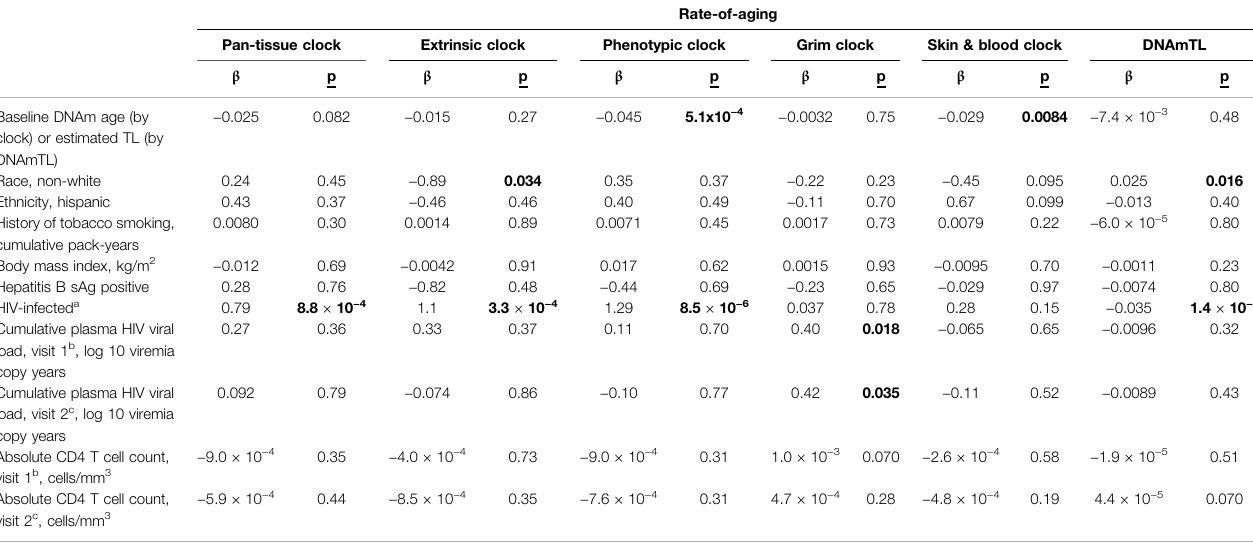
c ModelsadjustedforbaselineDNAmageorestimatedTL,race,ethnicity,tobaccosmoking,BMI,hepatitisBstatus,pluscumulativeviralloadatVisit2,andCD4countatVisit2,including only HIV-infected